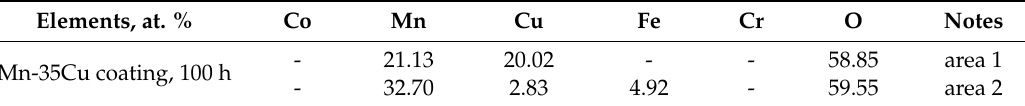
Figure 5. ( a ) ASR of Cu-Mn spinel coating with a temperature range of 500–800 ◦ C; ( b ) cross-section morphology of Cu-Mn spinel coating and the line scan position shown in the image; ( c ) a section with Cu-Mn spinel scale; ( d ) a section with Mn-rich scale. Table 2. Composition analysis of local areas in Figure 4 by EDS.